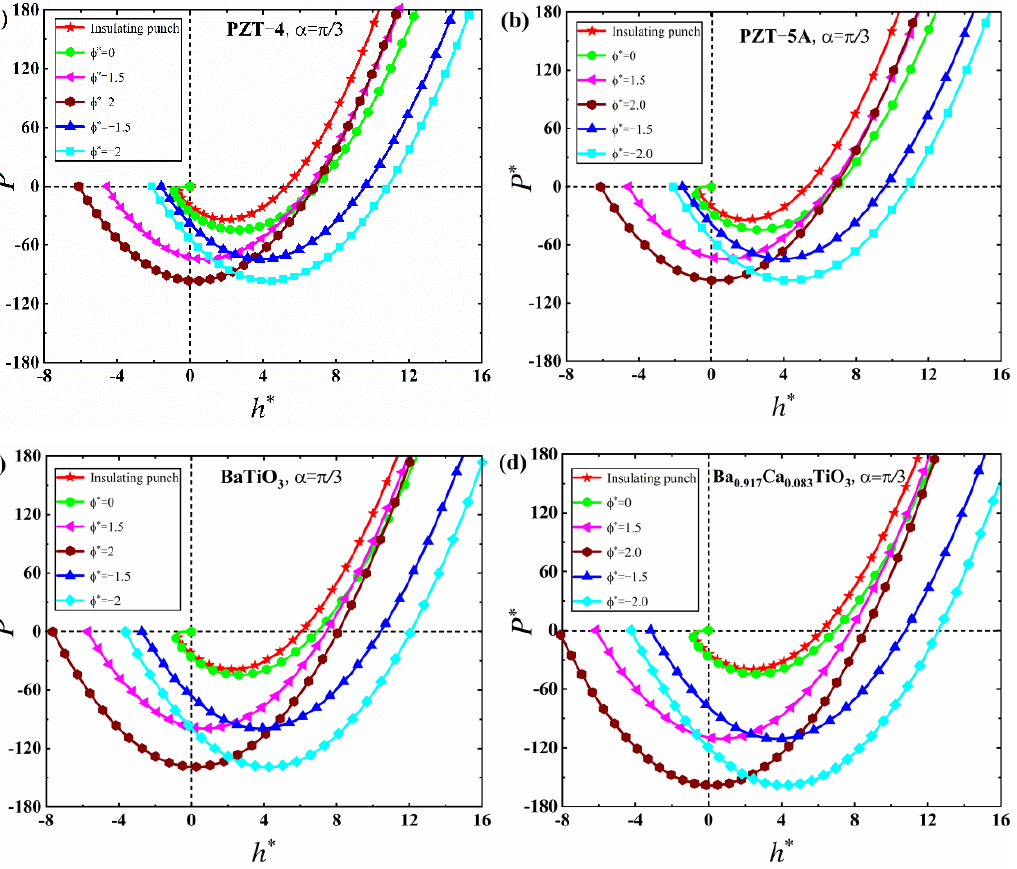
Figure 6. The dimensionless indentation force, P ∗ , as a function of the dimensionless indentation depth, h ∗ , at a fixed value of α = π /3 for the JKR model. ( a ) PZT-4. ( b ) PZT-5A. ( c ) BaTiO 3 . ( d ) Ba 0.917 Ca 0.083 TiO 3 .